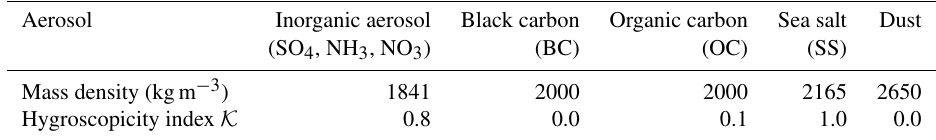
Table 1. Mass density and hygroscopicity index for different aerosol types.